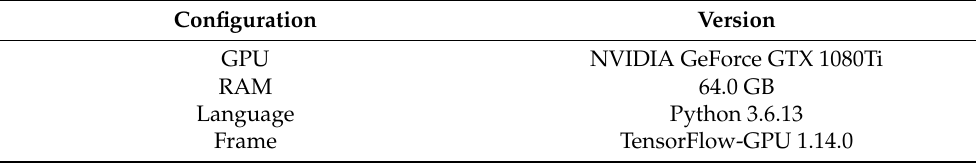
Table 2. The Hardware and Software